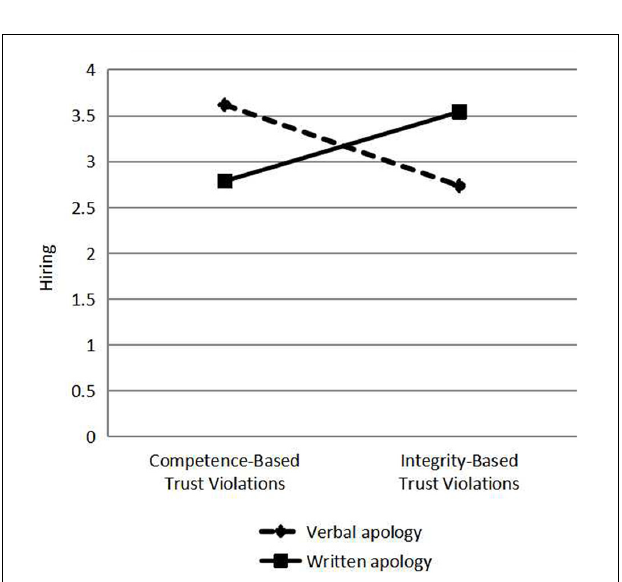
FIGURE 5 | The effects of violation type and violation response on